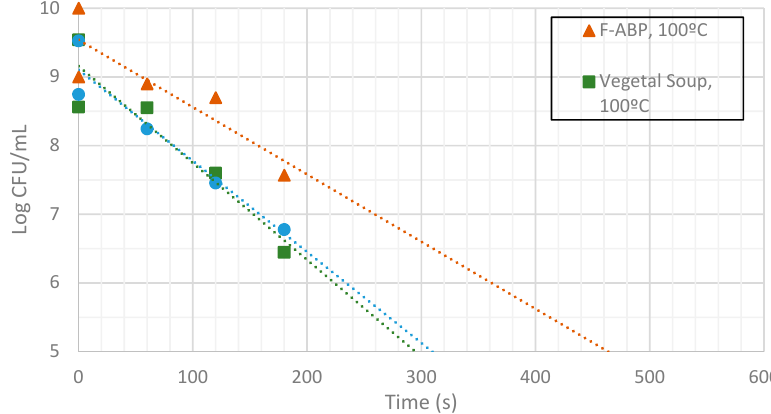
Figure 10. Measurement of CFUs in the substrates indicated at a target temperature of 100 °C.